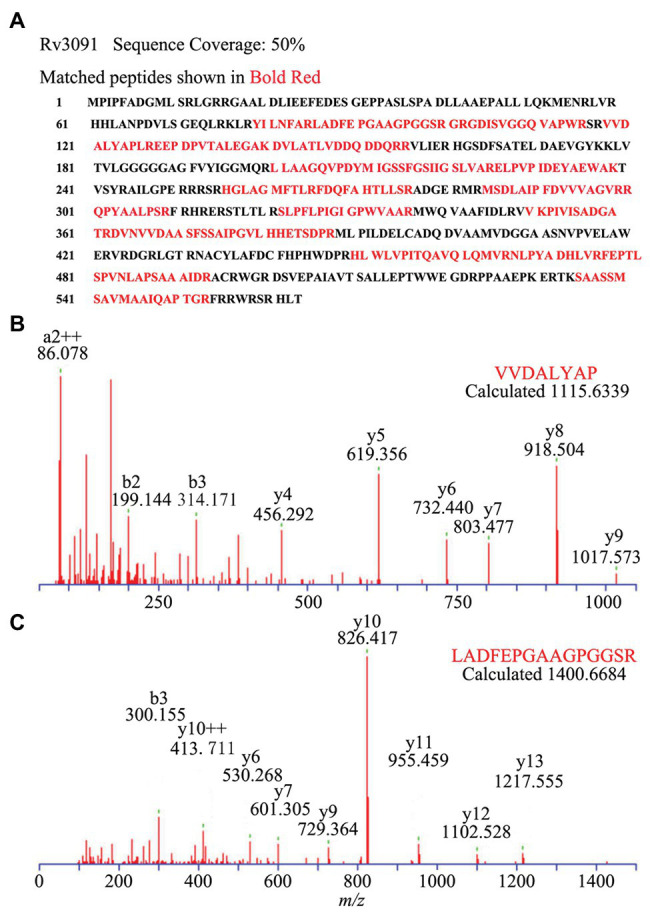
Subcellular localization of Rv3091 in culture filtrate of M. bovis BCG by Q-Excellent peptide mass fingerprint (PMF) spectrometry. (A) The sequence coverage of these fragments in Rv3091 is shown in bold red. (B) Doubly charged ion MS/MS of a fragmentation of Rv3091, VVDALYAP. (C) Doubly charged ion MS/MS of a fragmentation of Rv3091, LADFEPGAAGPGGSR.